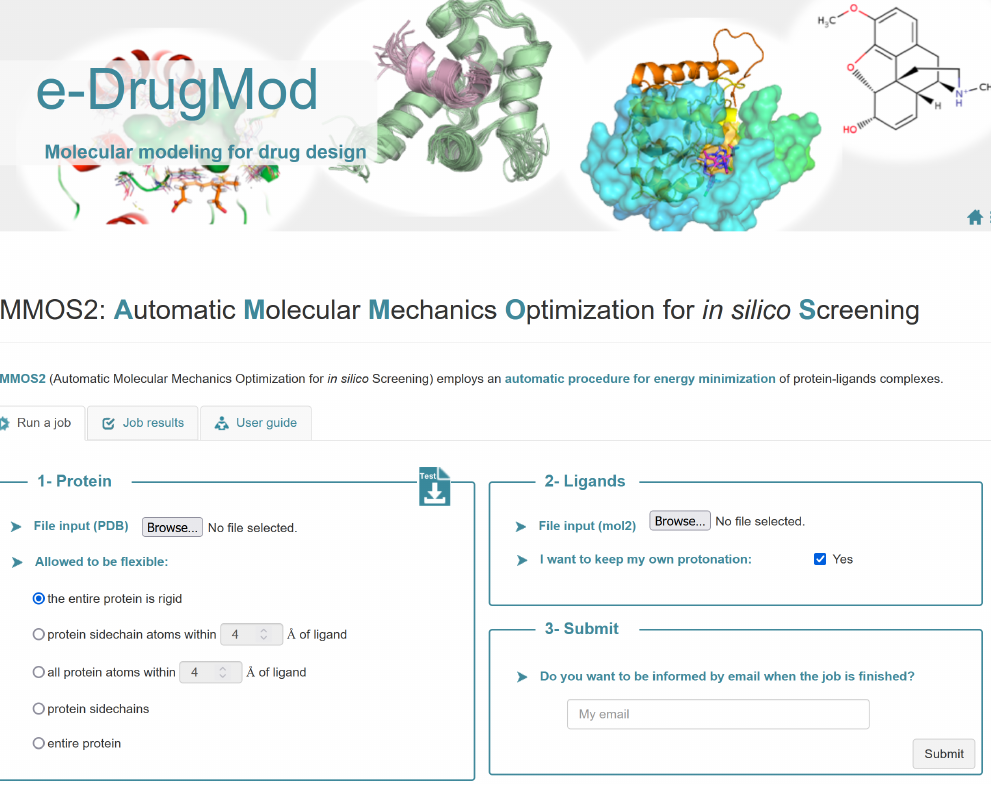
Fig. 1. AMMOS2 web